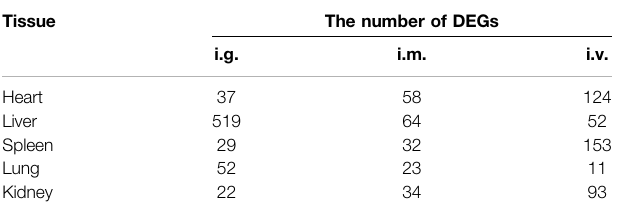
TABLE 2 | The number of DEGs of tissues (heart, liver, spleen, lung, and kidneys) from the mice exposed by the intragastric (i.g.) administration, intramuscular (i.m.) injection, and intravenous (i.v.) injection. (|log2 (fold change) | > 1, adjust p value < 0.05). Tissue